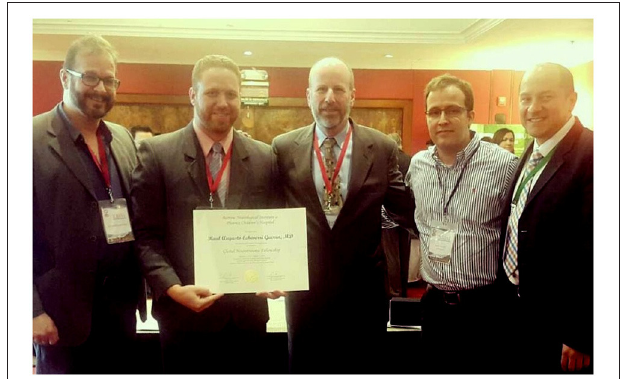
FIGURE 2 | Graduation ceremony of Dr. Raul Echeverri (Venezuela), who created an award for Venezuelan neurosurgical residents who traveled to Colombia for additional neurotrauma training within the fellowship program. From left to right, Dr. Ruy Monteiro (Brazil), Dr. Echeverri (Venezuela), Dr. David Adelson (US), Dr. Alvaro Soto (Colombia), and Dr. Andres M. Rubiano